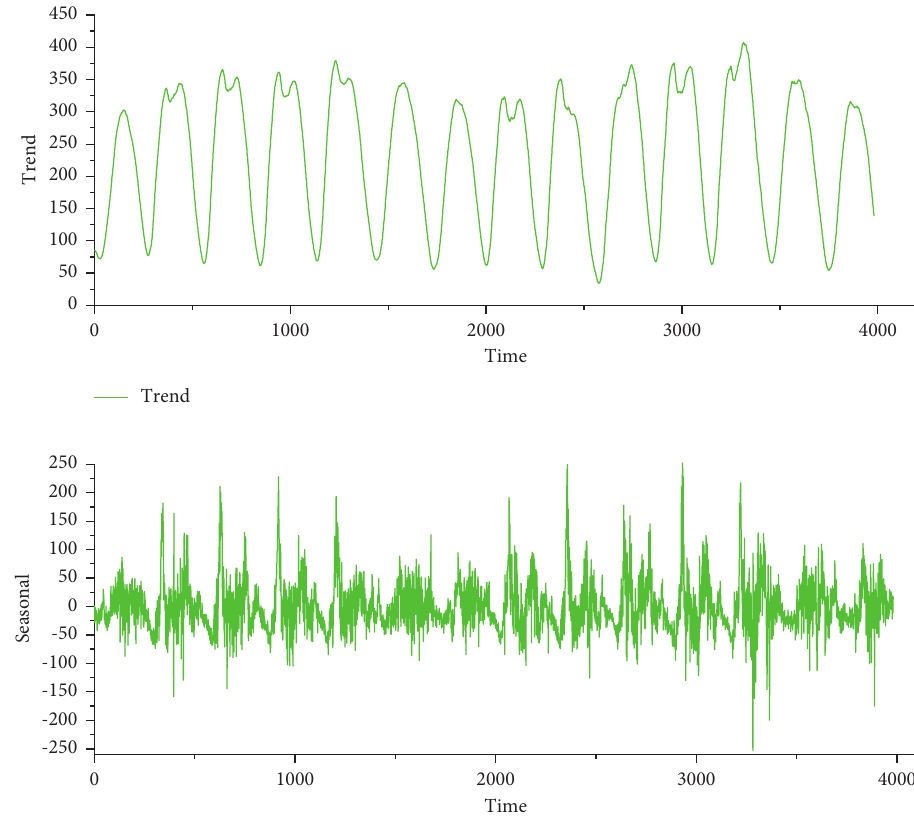
Figure 8: The trend component and seasonal